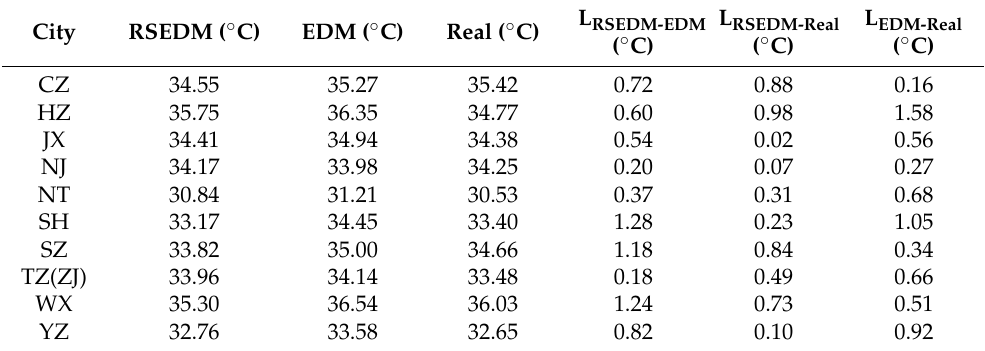
Table 4. Background land surface temperature fitted by the rotational-scan exponential decay model and exponential decay model of the second category of cities, and the difference between fitted temperature and the real temperature. Difference values in the table are absolute